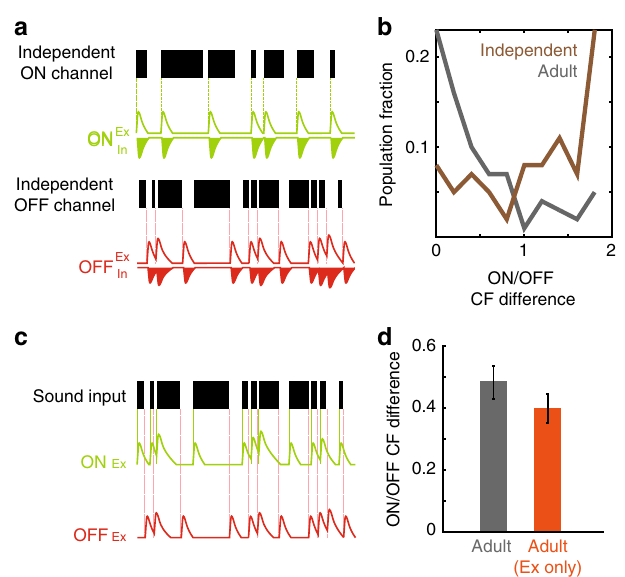
Fig. 3 Determinants of ON/OFF RF divergence in silico. a Input scheme to investigate role of sound alternation in RF divergence. In contrast to Fig. 2 (trained with input sequences where ON and OFF always followed each other), the network is presented with independent ON and OFF sequences where ON/OFF inputs need not necessarily alternate. b Final distribution of ON/OFF CF differences for neurons ( n = 100) trained with independent ON/OFF input sequences (brown). Adult population trained with natural alternating inputs shown for comparison (grey). c Input scheme to investigate role of fast evoked synaptic inhibition in RF divergence. Neurons receive evoked synaptic activity, driven by a sound sequence (black) that randomly switches ON (green dashed lines) and OFF (red dashed lines). Excitatory ON (green) and OFF inputs are evoked by sound onsets. Inhibitory inputs are omitted from the model. d Final mean difference between ON and OFF CF ( n = 100 cells) in excitation-only model (Ex only, orange). Adult excitation-inhibition results shown for comparison